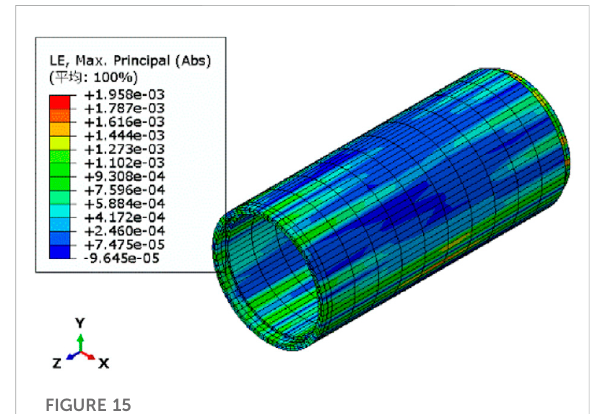
FIGURE 15 Nephogram of the concrete core of load stage II